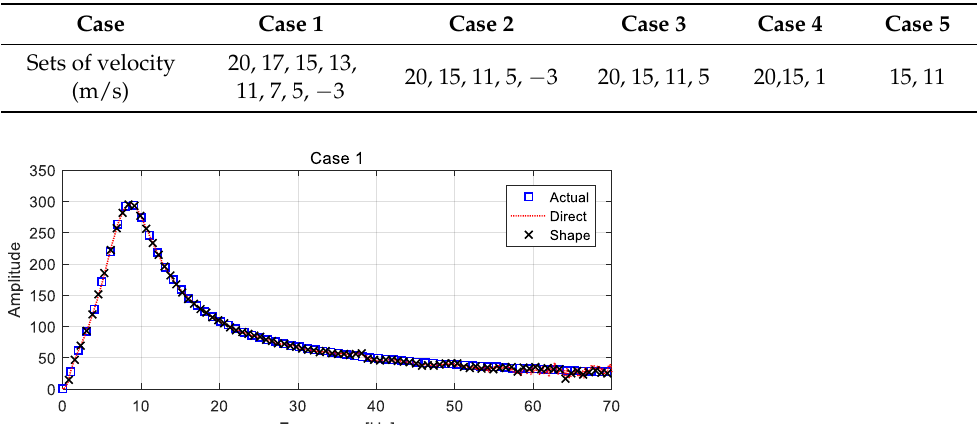
Figure 11. Frequency spectrum of the vehicle acceleration along DOF u 1 with velocities of [20, 15, − 3] m/s. Table 3. Combination of measured responses in different cases.